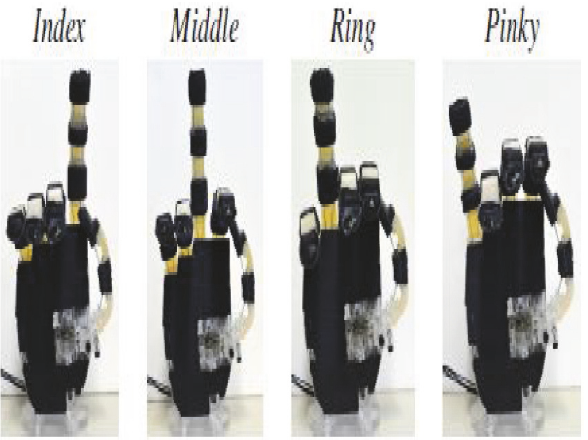
Figure 13: Movement of the fingers [8].